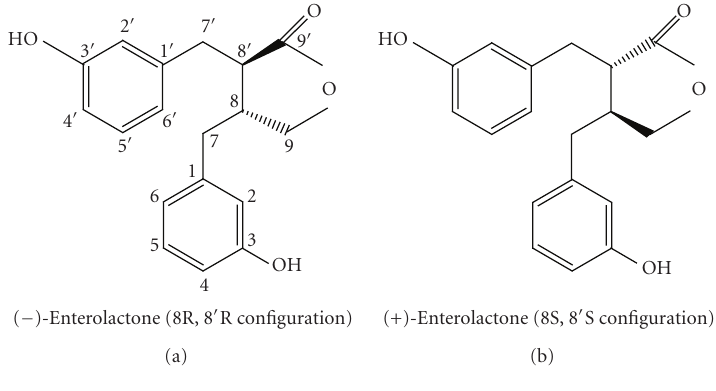
Figure 1: Chemical structure of enterolactone